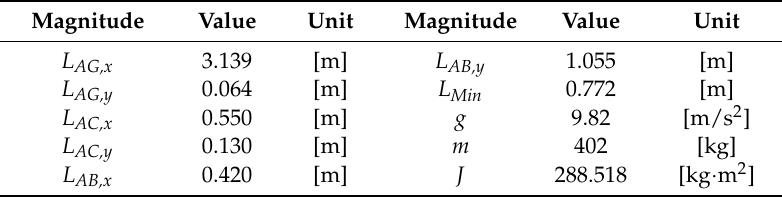
Table A1. Key parameters of the single-boom